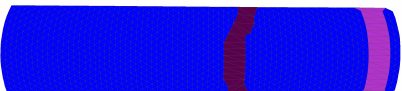
Figure 11. Color-labeled regions of triangles with || (cid:126)t rel, 2 D || > δ at 0.22 ms.